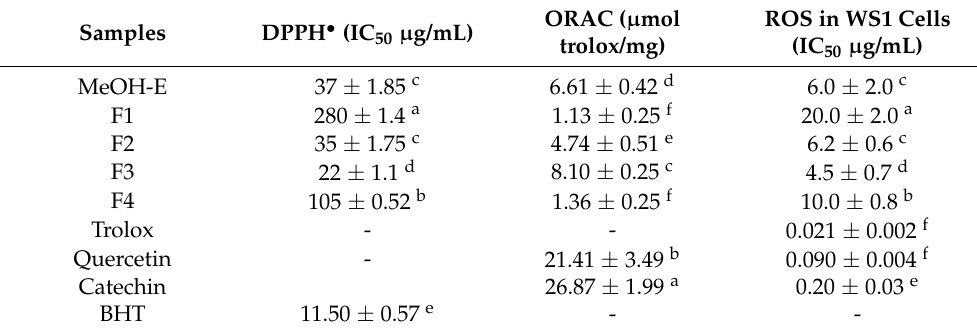
Table 3. Ability of R. raetam MeOH-E and the subsequent fractions F1, F2, F3 and F4 to scavenge DPPH • and RO 2 • , and to reduce intracellular levels of reactive oxygen species in WS1 cells.